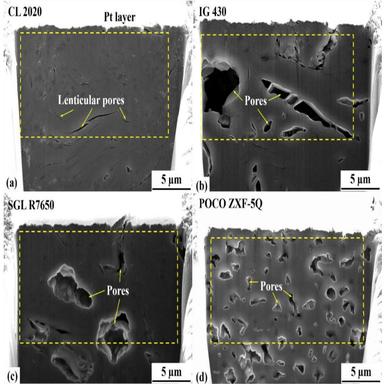
Four example images of FIB tomography serial sectioning and view acquired via Dualbeam (sectioning by FIB, imaging by SEM) showing: (a) CL 2020 graphite, (b) IG 430 graphite, (c) SGL R7650 graphite and, (d) POCO ZXF-5Q graphite. On the top of each cross-sectional view is the protective Pt layer deposited with high brightness shown in white colour. Dashed boxes indicate approximately the volumes for porosity segmentation and 3D reconstruction as in 7. (For interpretation of the references to colo